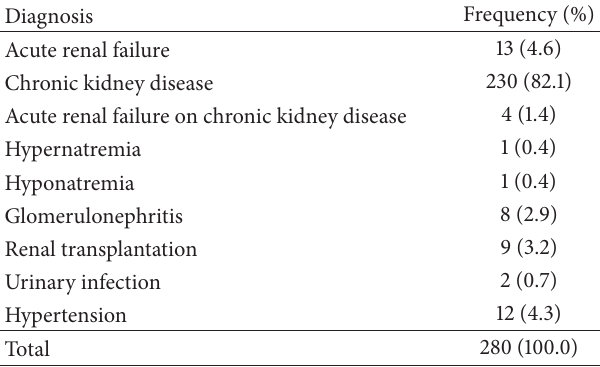
Table 1: Diagnosis of the